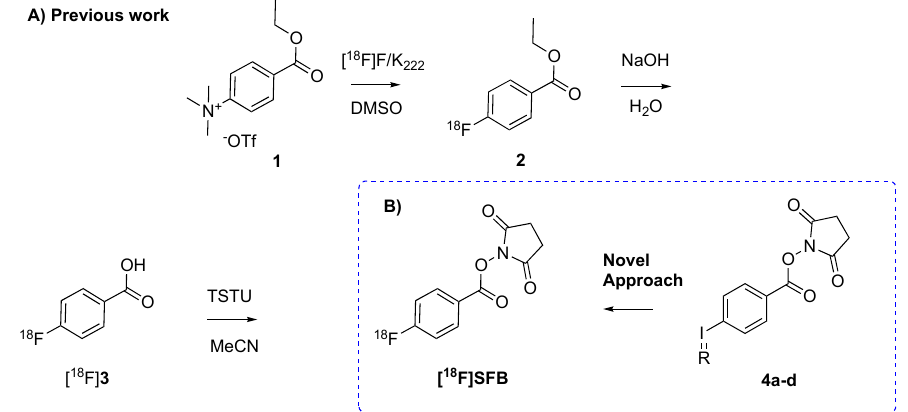
Figure 1. Standard procedure vs. novel one-step approach; ( A ) 3-step synthesis of N -Succinimidyl-4-[ 18 F]Fluorobenzoate ([ 18 F]SFB), ( B ) Novel synthesis approaches based on spirocyclic iodonium ylide